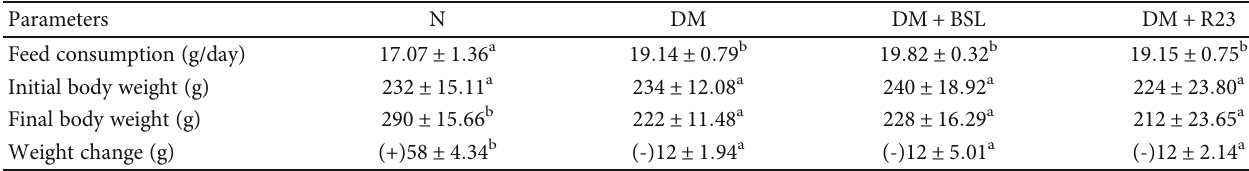
Table 1: Feed consumption and body weight in experimental groups.